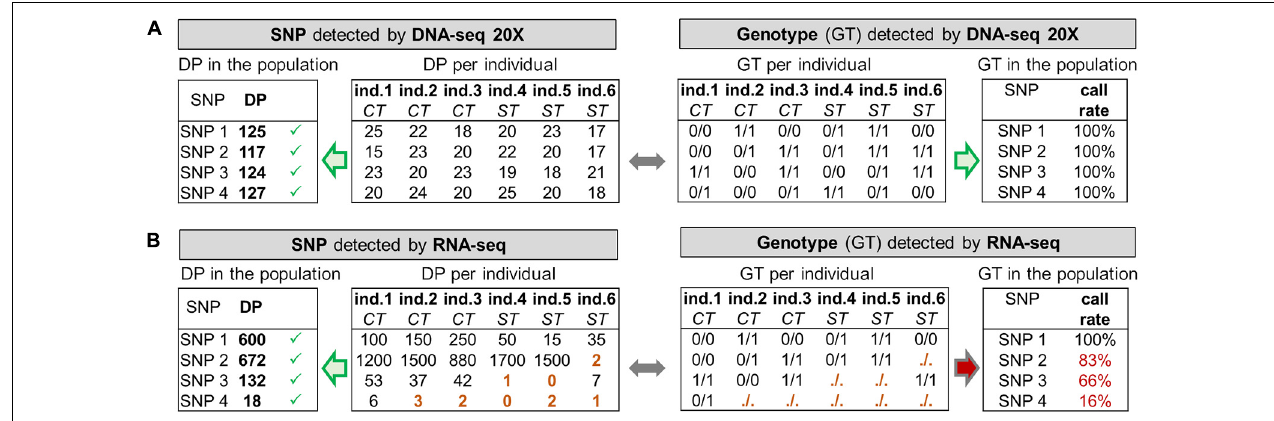
FIGURE 1 | Toy example with simulated data illustrating the need for read depth (DP) filters in RNA-seq and differences with DNA-seq. (A) DNA-seq data offers a globally homogeneous genome coverage (20X in our case), all SNPs are therefore detected by GATK at the individual level with a DP of 20 reads on average ( “DP per individual” ), and at the population level with a DP of 6 × 20 = 120 reads on average ( “DP in the population resulting from the addition of ”DP per individual”) . All genotypes (GT) can therefore be computed at the individual level ( “GT per individual” ), resulting in a genotype call rate of 100% for every SNP ( “GT in the population” ). (B) RNA-seq data offers a heterogeneous coverage of the genome depending on the expression of the genes harboring the SNPs. At the population level, 4 SNPs having a sufficiently high DP are detected by GATK. At the individual level, SNP 1 shows good read coverage across all samples whereas SNP 3 is on a gene that has a lower expression, in particular in the stress (ST) condition compared to the control (CT). SNP 4 is on an overall very lowly expressed gene. In terms of genotype (GT) per individual , some cannot be provided by GATK (noted “./.”) because of a too low DP (i.e., 5 reads, see brown GT and DP) and are not considered for the GT call rate. For SNP 3, most of the individuals from the ST condition have no GT and for SNP 4, only one GT is called whereas in both case the SNP is detected at the population-level. “GT in the population” provides for each SNP their call-rate for the genotypes (CR): SNP 1 has 100% of the samples with a GT whereas SNP 4 has 16% and cannot be used to compute meaningful genotype